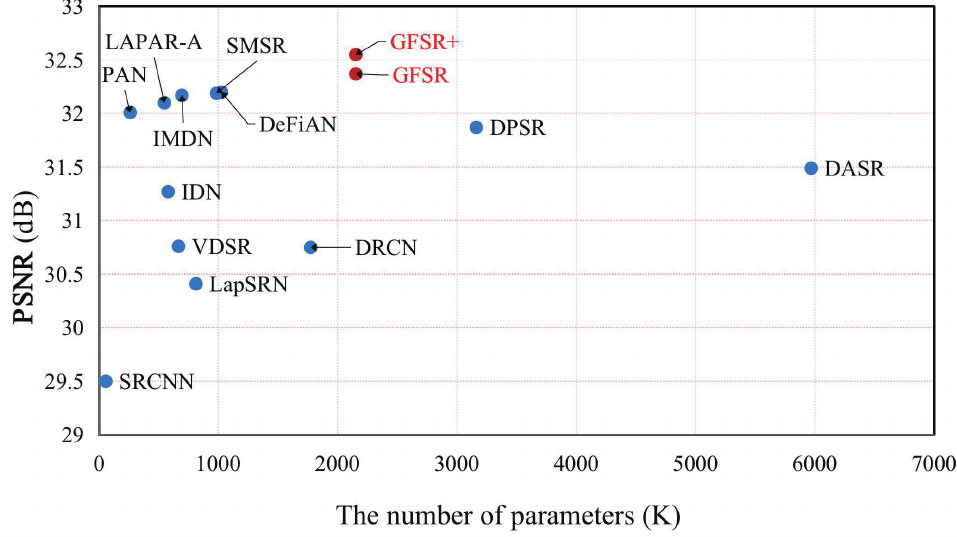
Figure 12. Comparison of performance and number of parameters of different methods. Results are evaluated on Urban100 with scaling factor